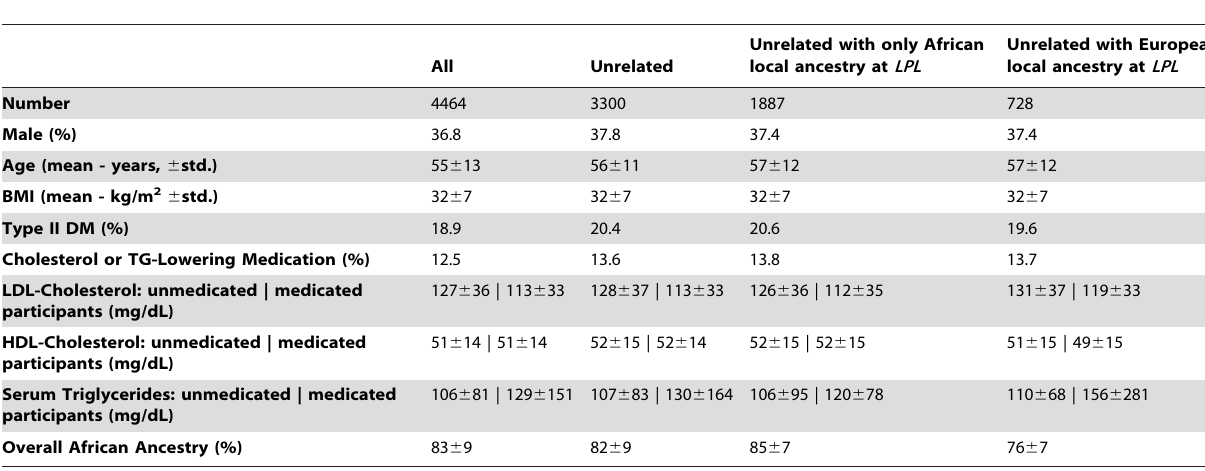
Table 1. Demographic Characteristics for the Genotyped Jackson Heart Study